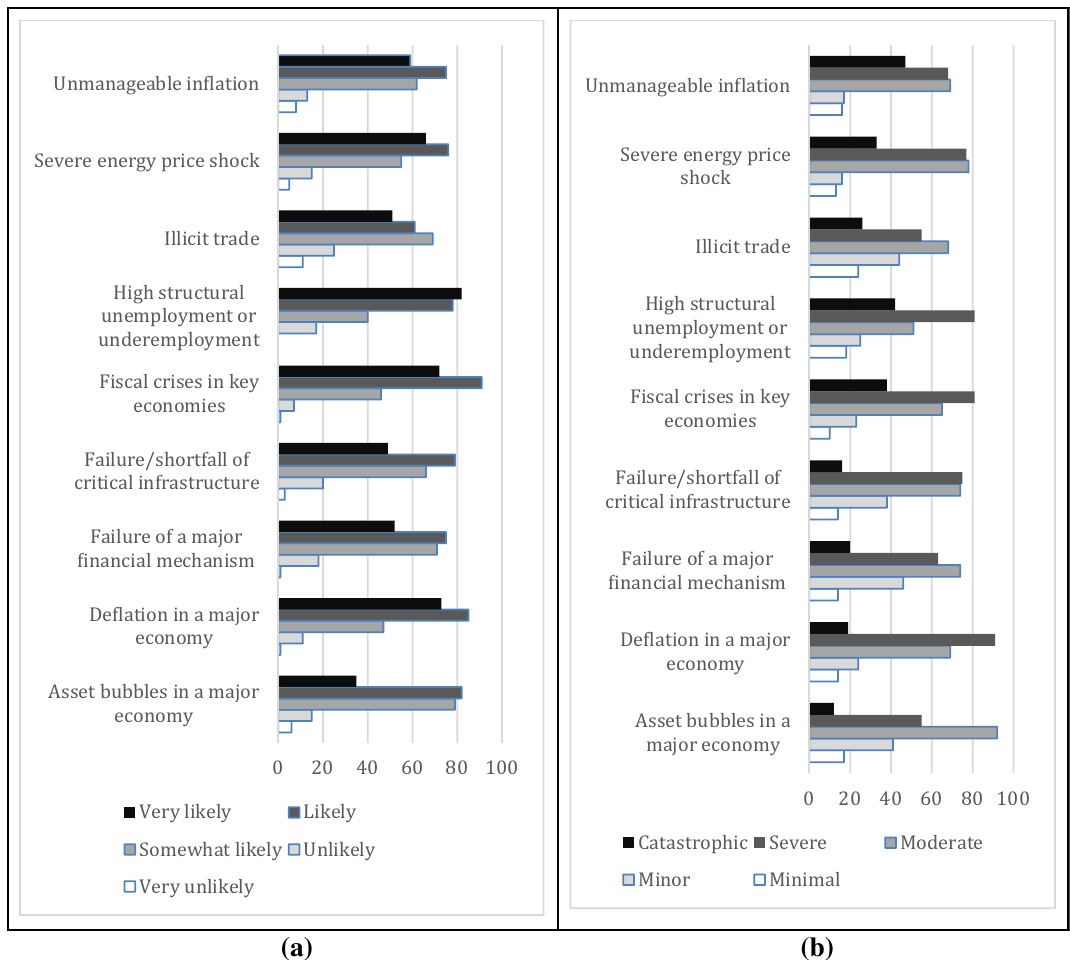
Fig. 1 Stated likelihoods ( a ) and consequences ( b ) of the global economic risks by the surveyed small and medium enterprises in